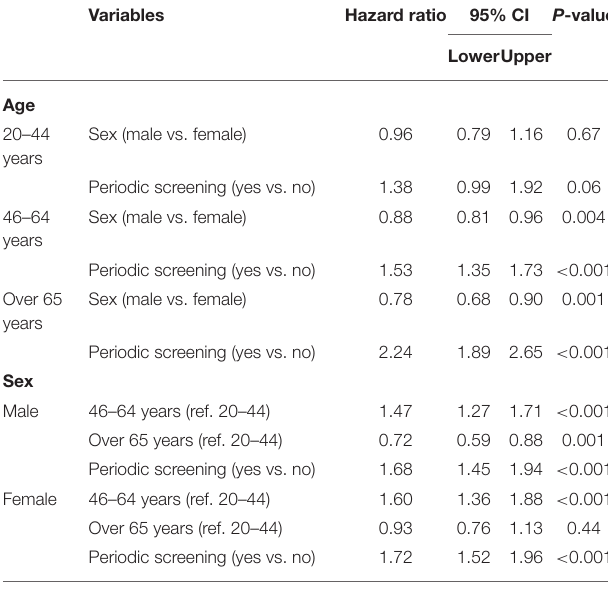
TABLE 4 | Cox regression of diabetic retinopathy (DR) severity ( N = 3294).